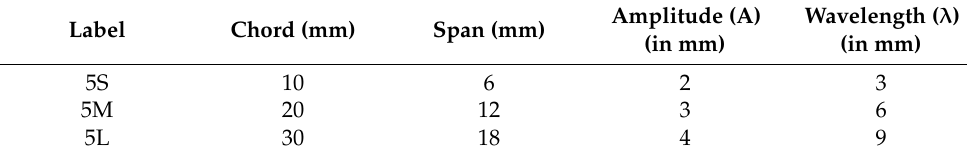
Table 2. Label and dimensions of the test